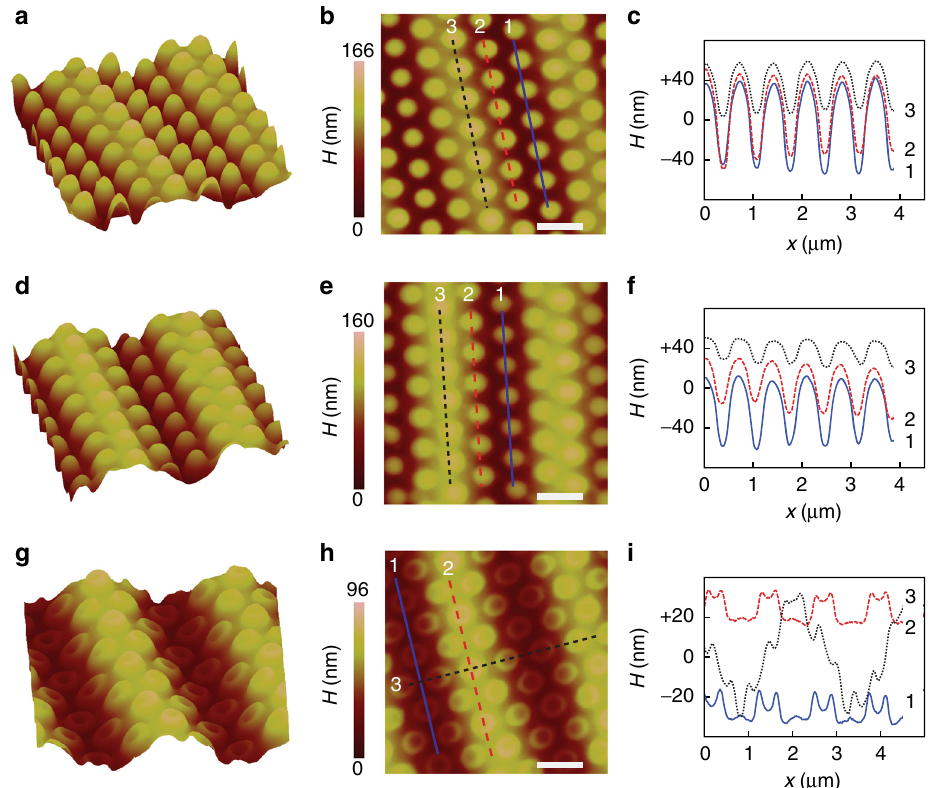
Fig. 4 EHDL-generated nanocones and nanovolcanos. AFM scans of EHDL results obtained with the UV exposure dose of the two-beam interference lithography set to a – c 1.2 J cm – 2 , d – f 1.8 J cm – 2 , and g – i 3.6 J cm – 2 . The fi rst and second columns show the fi nal textures in the bird ’ s eye and top views, respectively. The third column shows their cross-sectional pro fi les along the lines in the second column. While the low dose, narrow-gap EHDL produced nanocone array as shown in the fi rst two rows, the high dose, wide-gap EHDL resulted in a nanovolcano array as shown in the third row. (Scale bars: 1 μ